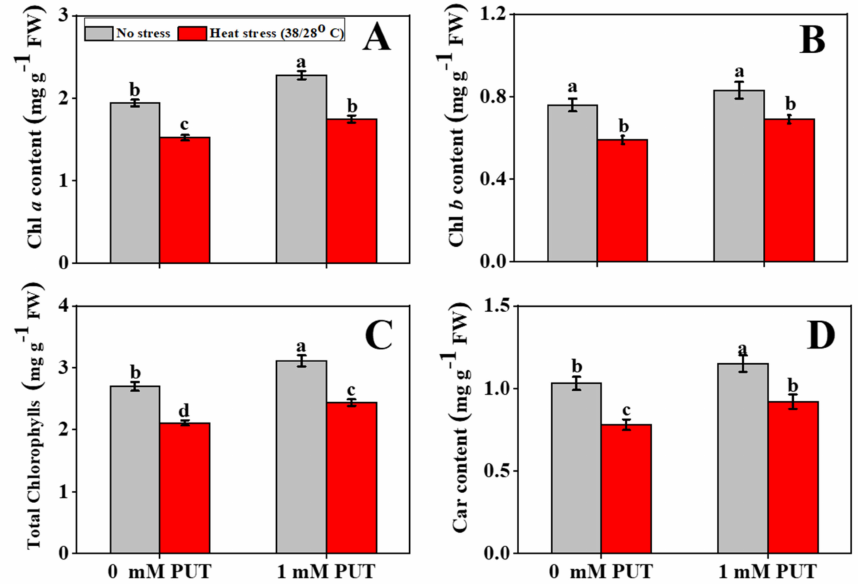
Figure 1. Interactive effects of Putrescine (Put) and high temperature on Chlorophyll (Chl) and carotenoid (Car) content in tomato seedlings. ( A ) Chl a content, ( B ) Chl b content, ( C ) Total Chl content, and ( D ) Car content. The data denote the mean value ± standard error (n = 3). Different alphabetic letters represent the significant differences among the treatments at p < 0.05, according to Tukey’s